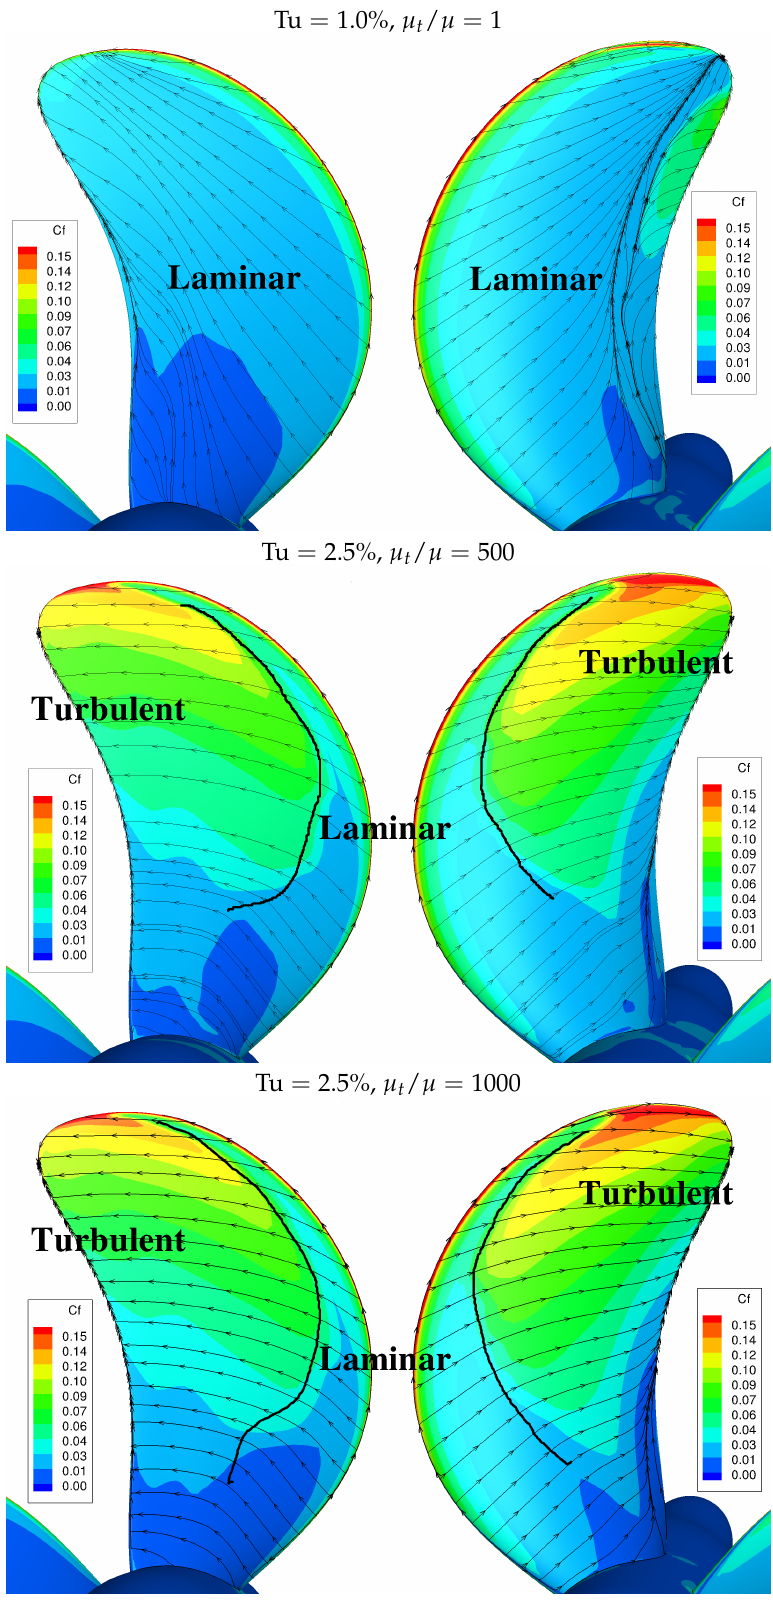
Figure 10. Influence of the inlet turbulence quantities on the propeller blade flow. Limiting stream- lines and skin friction coefficient using the γ − ˜Re θ Pressure side ( left ) and suction side ( right